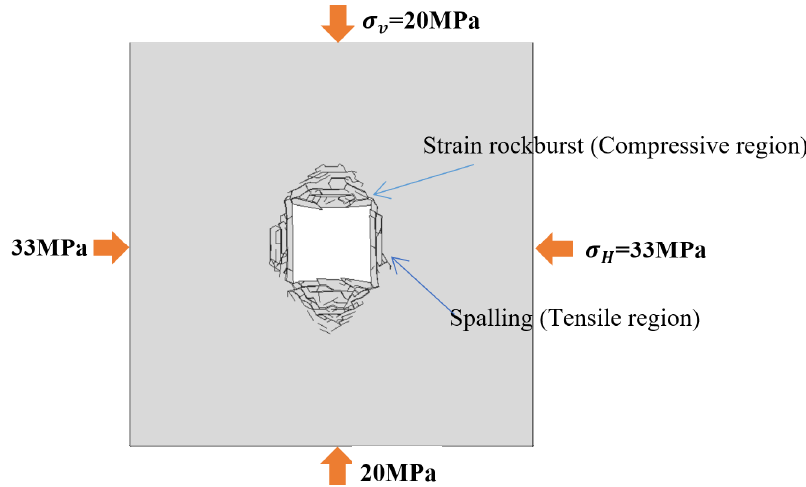
Figure 18. Tunnel failure caused by excavation under pre-stressed state.